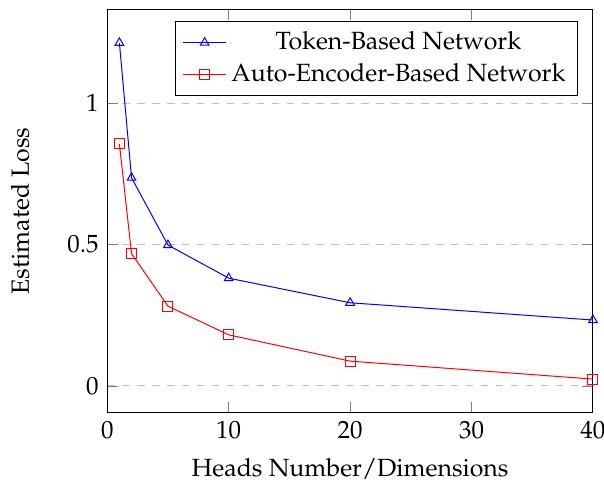
Figure 9. The averaged estimated loss with different heads number/dimensions.